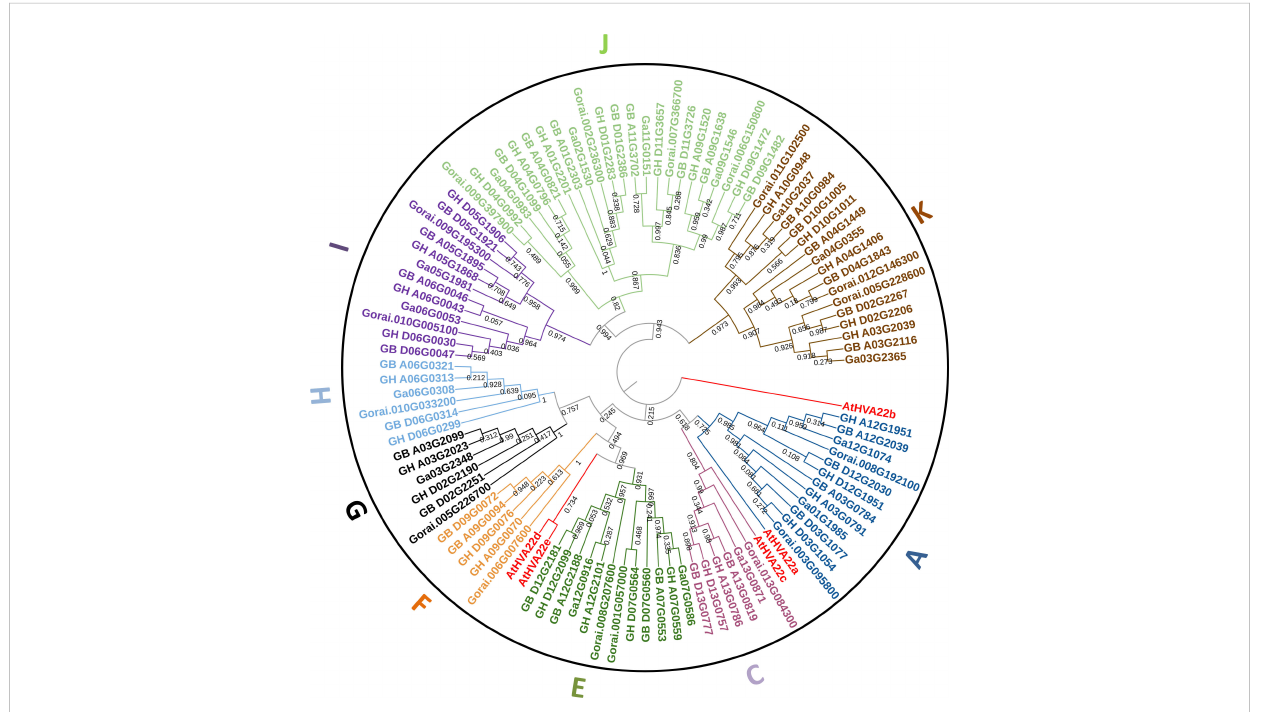
FIGURE 1 The phylogenetic tree of HVA22s from A. thaliana and four cotton species. The bootstrap value on the branch lines were from 0.03 to